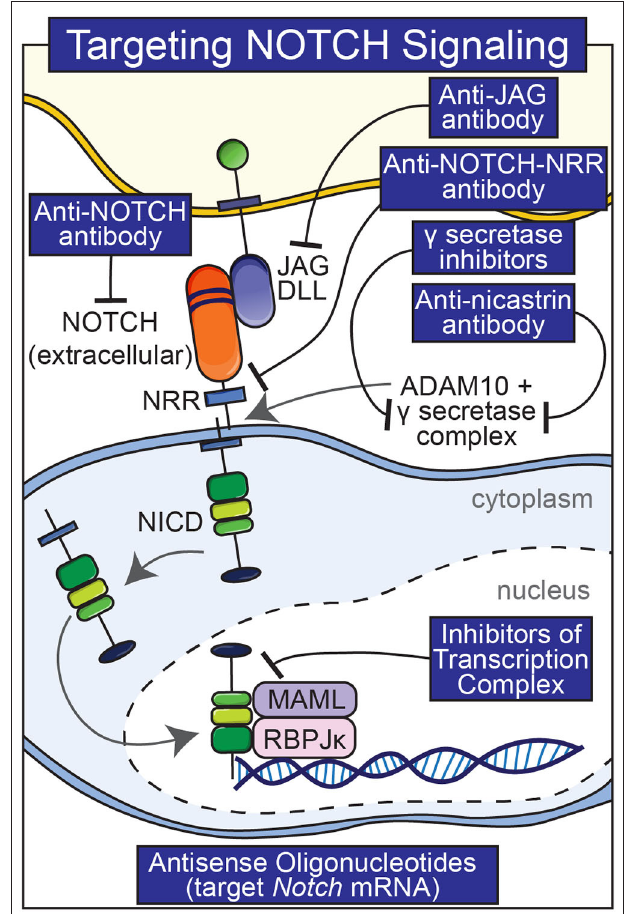
FIGURE 3 | Pharmacological interventions to temper Notch signaling. Antibodies to various components of Notch signaling (Notch, Notch NRR, JAG, nicastrin), inhibitors of the γ -secretase complex, and small peptides that preclude the formation of a Notch NICD, RBPJ κ , MAMAL complex are